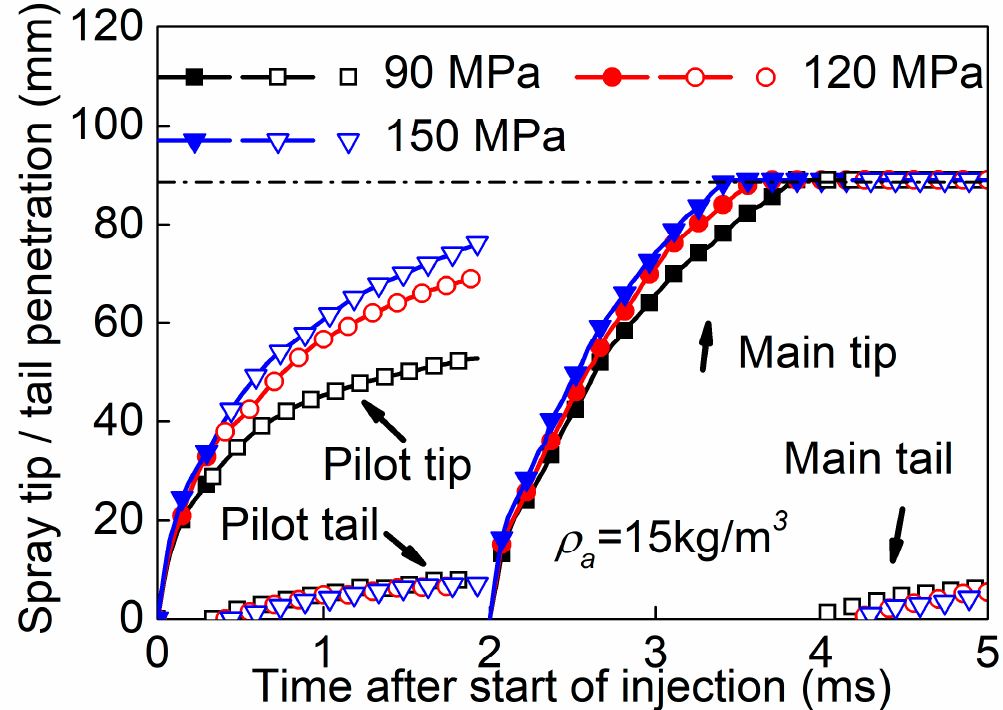
Figure 9. Results of spray tip and tail penetrations when applying the pilot-main injection strategy under various injection pressures.